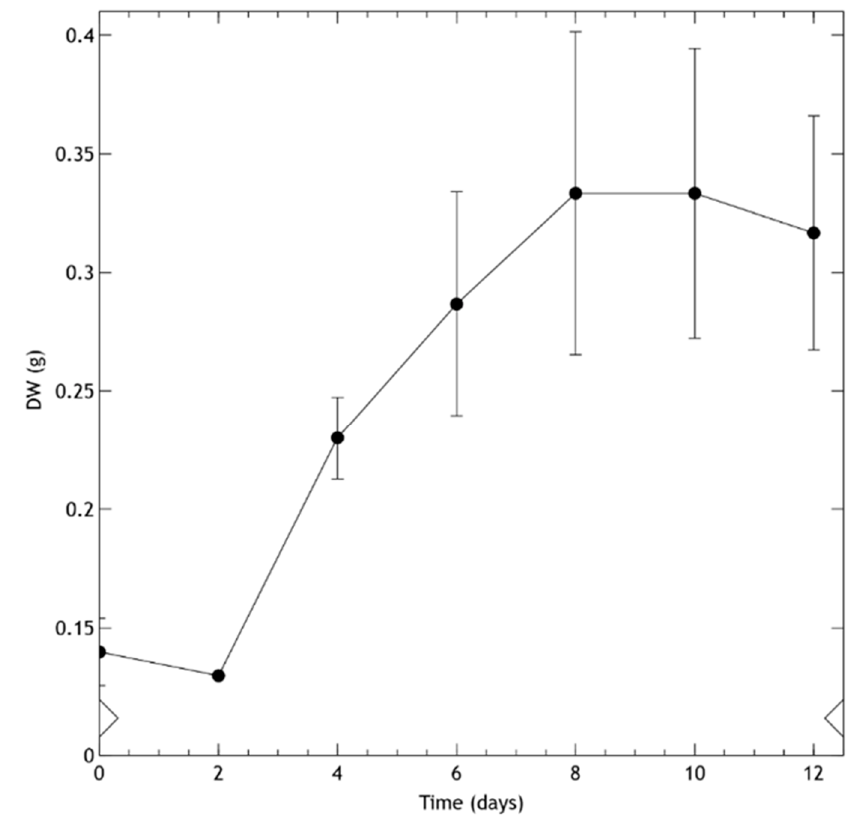
Figure 3. Kinetic growth of cell suspension culture of Helianthella quinquenervis expressed in dry weight (DW) g/150 mL. Values are means ± S.D. of the measurement from three flasks.